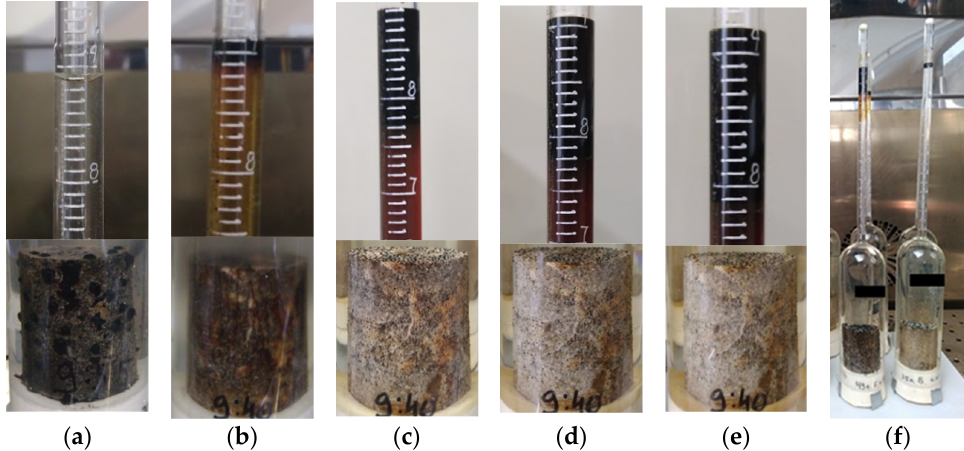
Figure 6. Photo of cores (Bashkirian stage) and displaced oil in the Amott cells: ( a ) Initial (brine) after 1 day; ( b ) After 1 day of aging in Composition-1 solution; ( c ) After 10 days of aging in Composition-1 solution; ( d ) After 19 days of aging in Composition-1 solution; ( e ) After 30 days of aging in Composition-1 solution; ( f ) General view of the Amott cells.